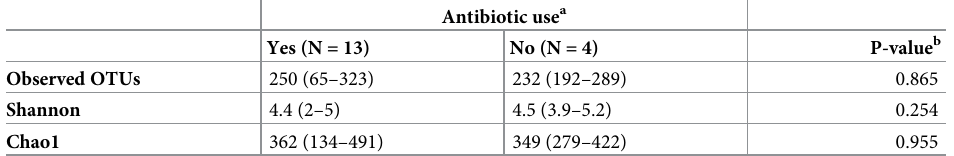
Table 3. Juvenile green turtle fecal bacterial alpha diversity in individuals at the admission time point that did and did not receive antibiotics.